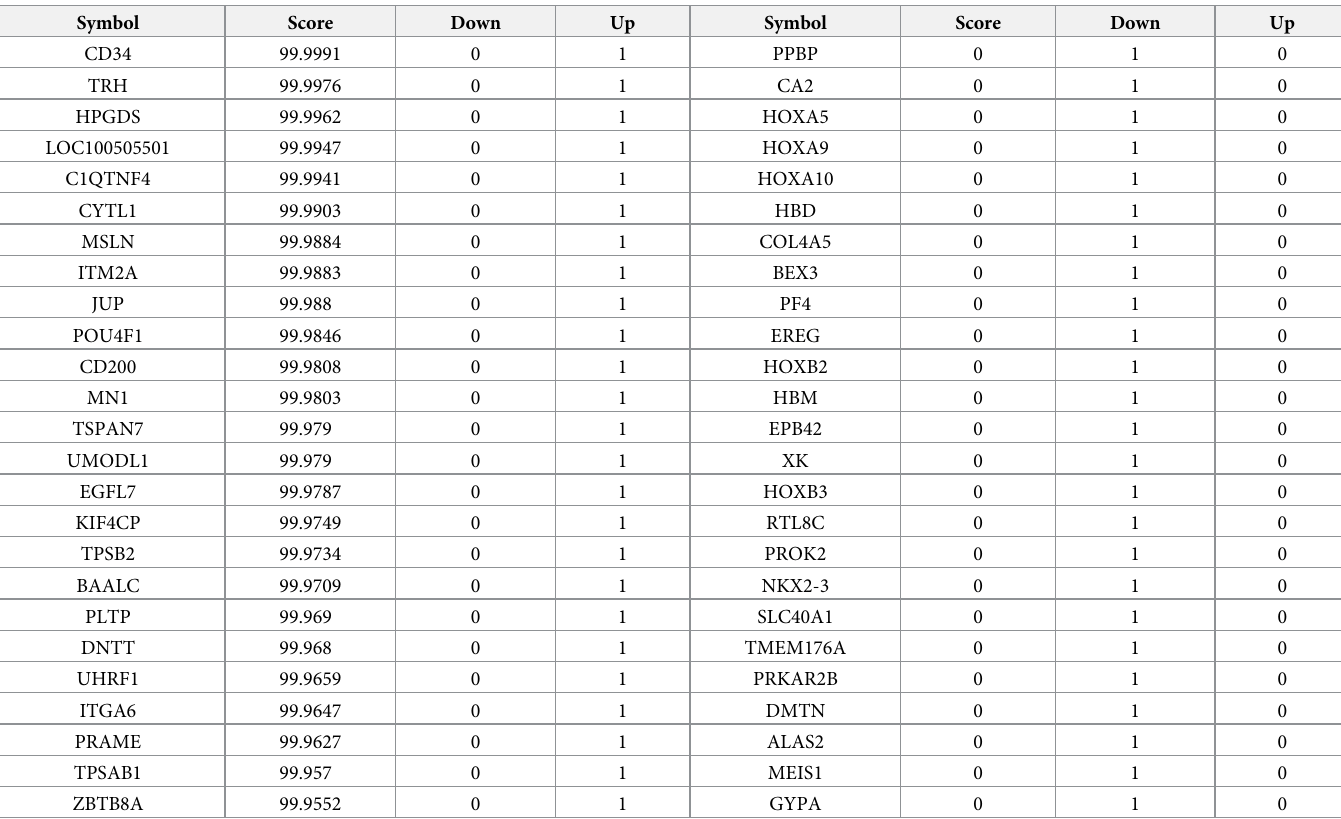
Table 1. Differential gene expression patterns using